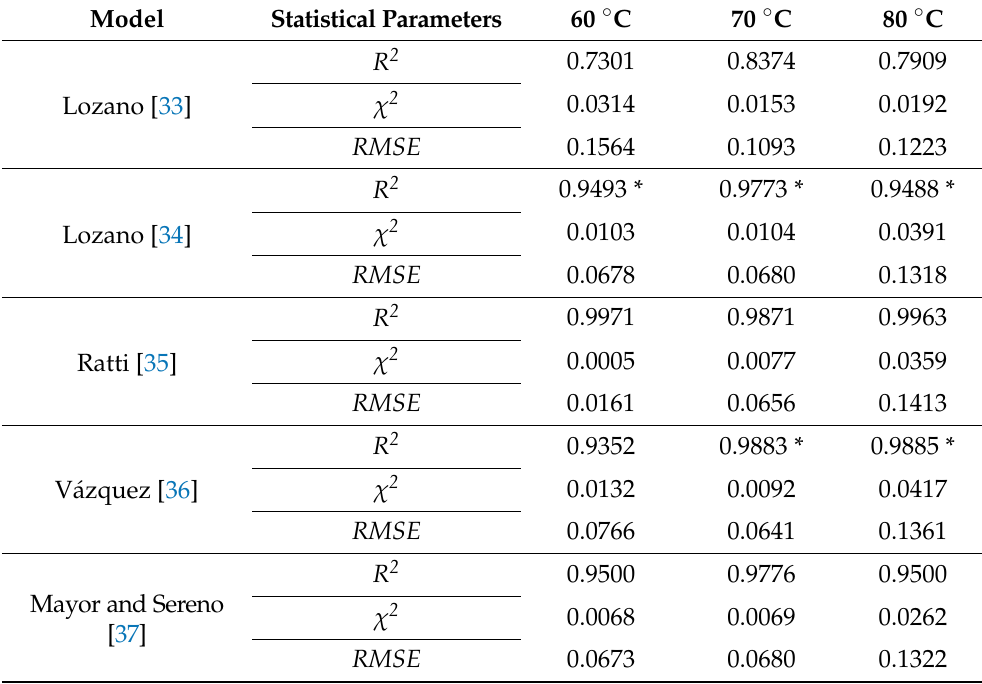
Table 4. Statistical results obtained from various empirical shrinkage